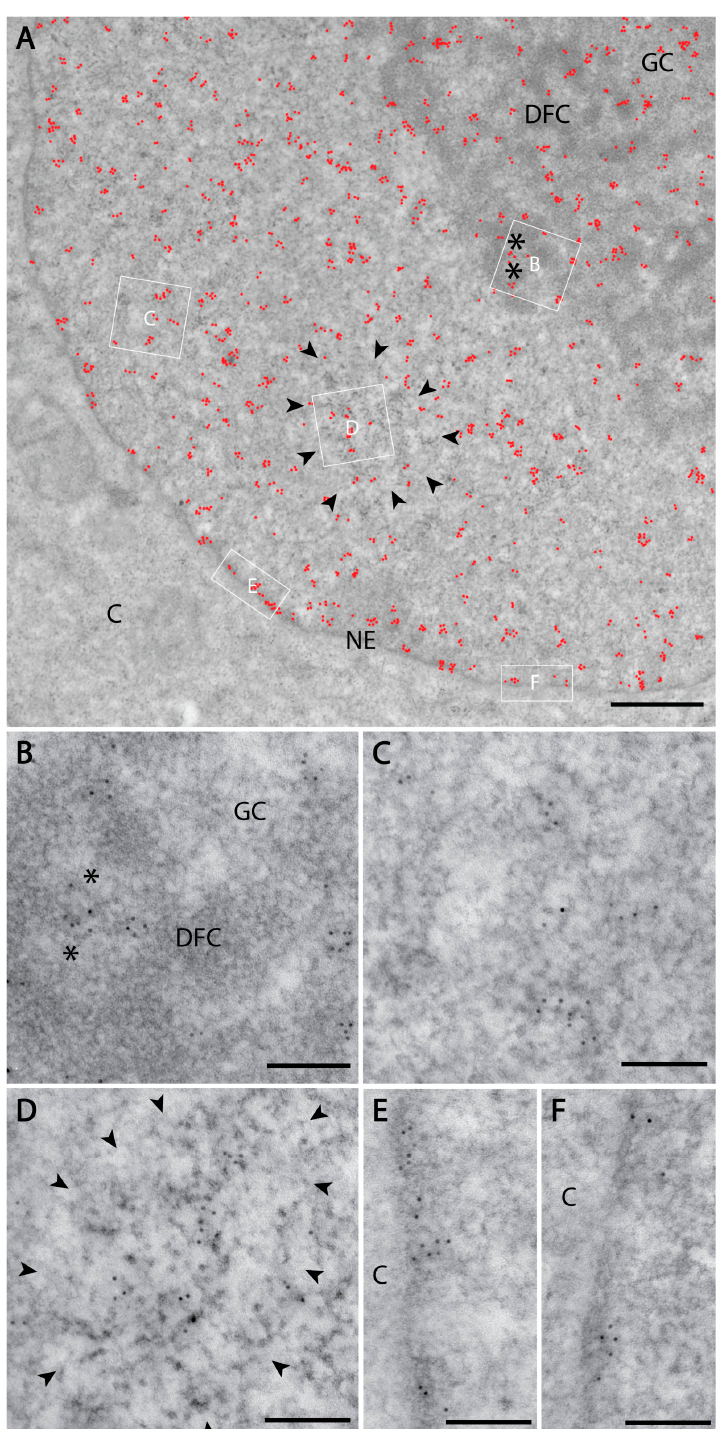
Figure3. NuclearPI(4)Plocalisationaccordingtotransmissionelectronmicroscopy. Electronmicroscopy revealed the localisation of PI(4)P: ( A ) to the cell nucleus (red dots). Black asterisk—fibrillar centre; DFC—dense fibrillar component; GC—granular component; NE—nuclear envelope; C—cytoplasm; black arrowheads delineate nuclear speckles. ( B ) In the nucleolus, PI(4)P is enriched in the DFC and also GC, but it does not localise to the FC. ( C ) In the nucleoplasm, PI(4)P is enriched on chromatin. ( D ) PI(4)P is also enriched at the nuclear speckles, and nuclear envelope ( E , F ) where it localises to nuclear lamina. ( B – F ) are high magnification insets from the same